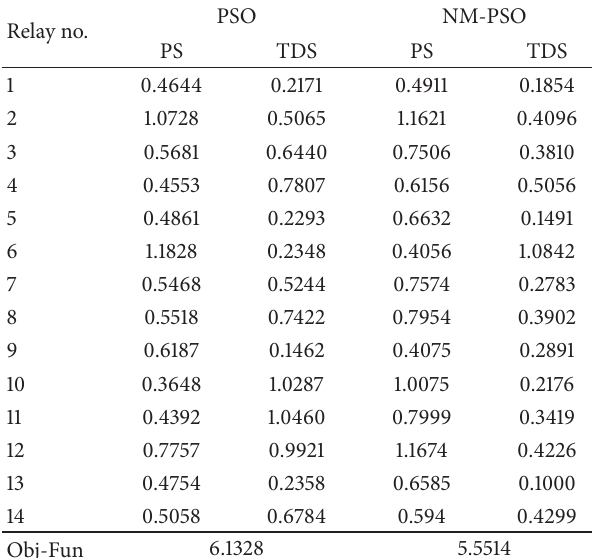
Table 2: Results of a conventional PSO and the proposed NM-PSO in a fixed network